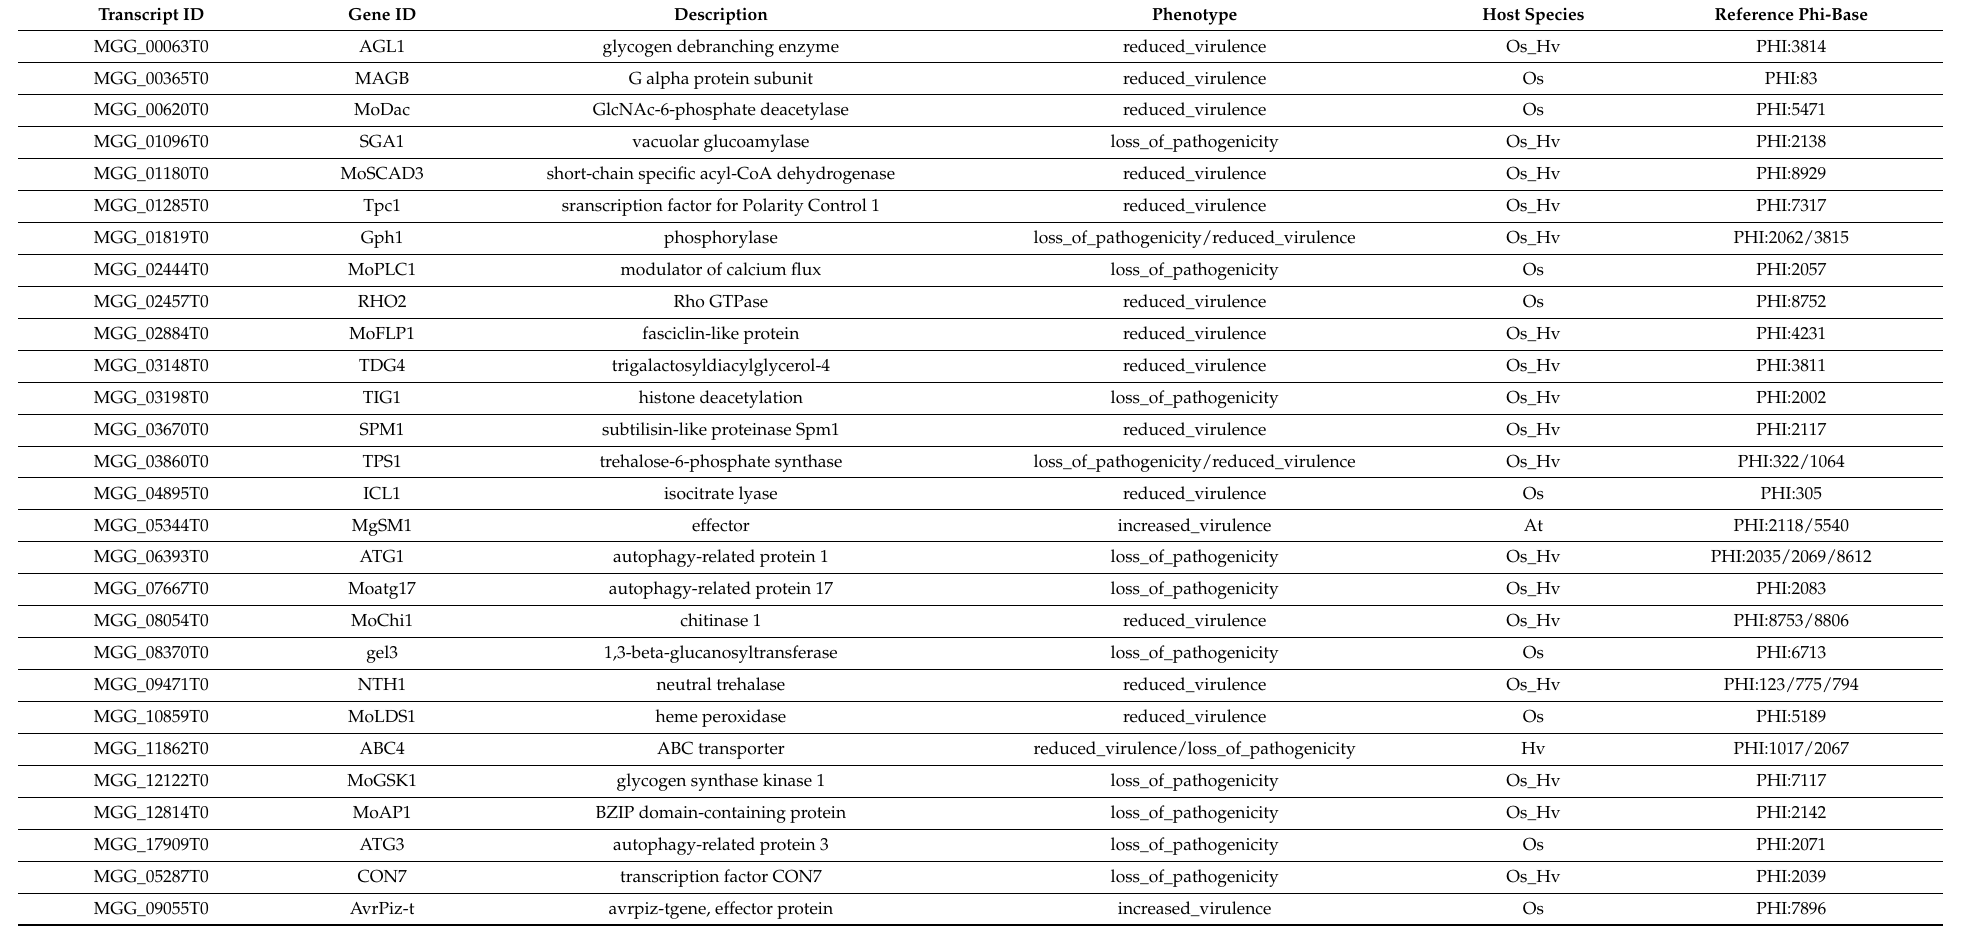
Table 8. Predicted RNAi targets with known infection-impaired phenotypes in the corresponding M. oryzae knock-out (KO)